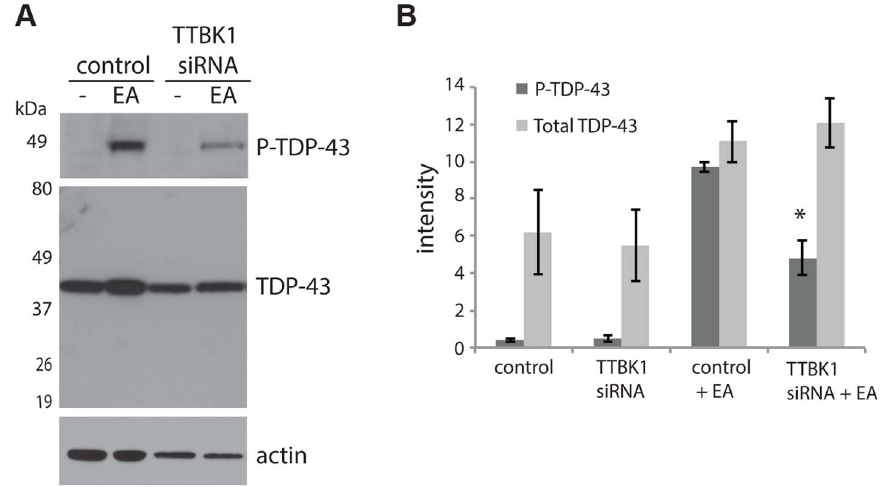
Figure3.ReducedTTBK1protectsagainstTDP-43phosphorylation (A)NSC-34cellstreatedwithsiRNAtargetingTTBK1exhibitreducedTDP-43 phosphorylation following induction of P-TDP-43 with ethacrynic acid (EA). (B) Quantitative analysis of band intensities from three independent replicate siRNA experiments. Band intensities are graphed in arbitrary units. * P =0.025 versus control + EA, Student’s